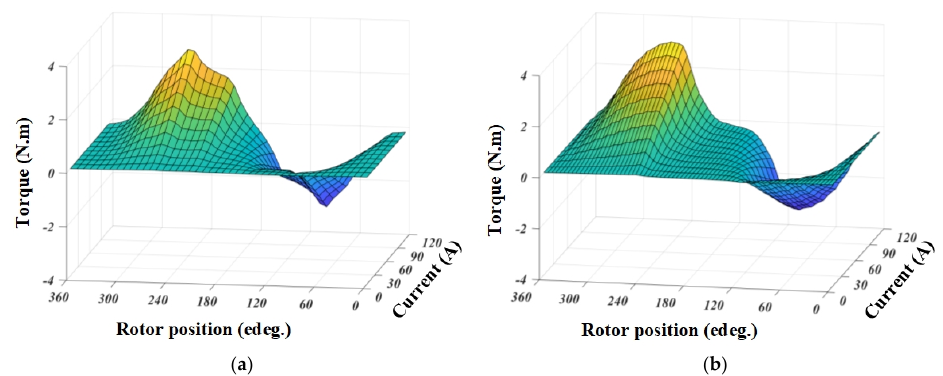
Figure 8. Three-dimensional torque curves. ( a ) Traditional 12/8 SRM; ( b ) Proposed 6/5 SRM.